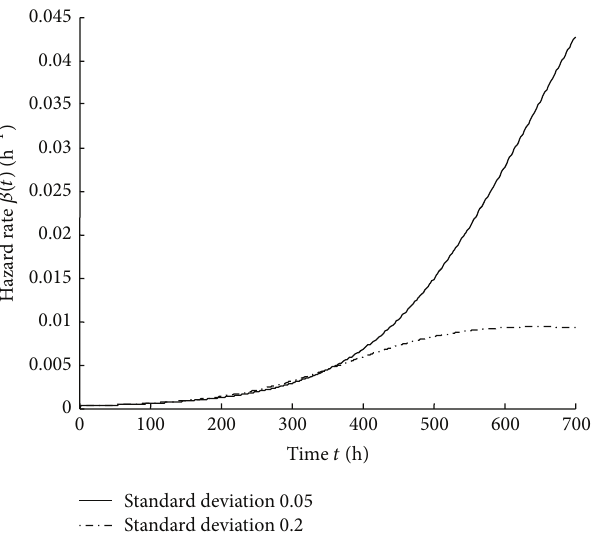
Figure 6: Hazard rate curves with different standard deviations of 𝑘 .